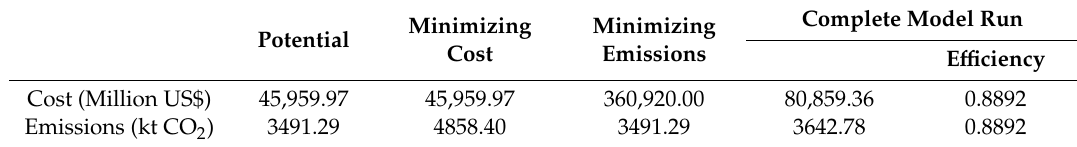
Figure 5. Minimum Environmental Emissions Network.